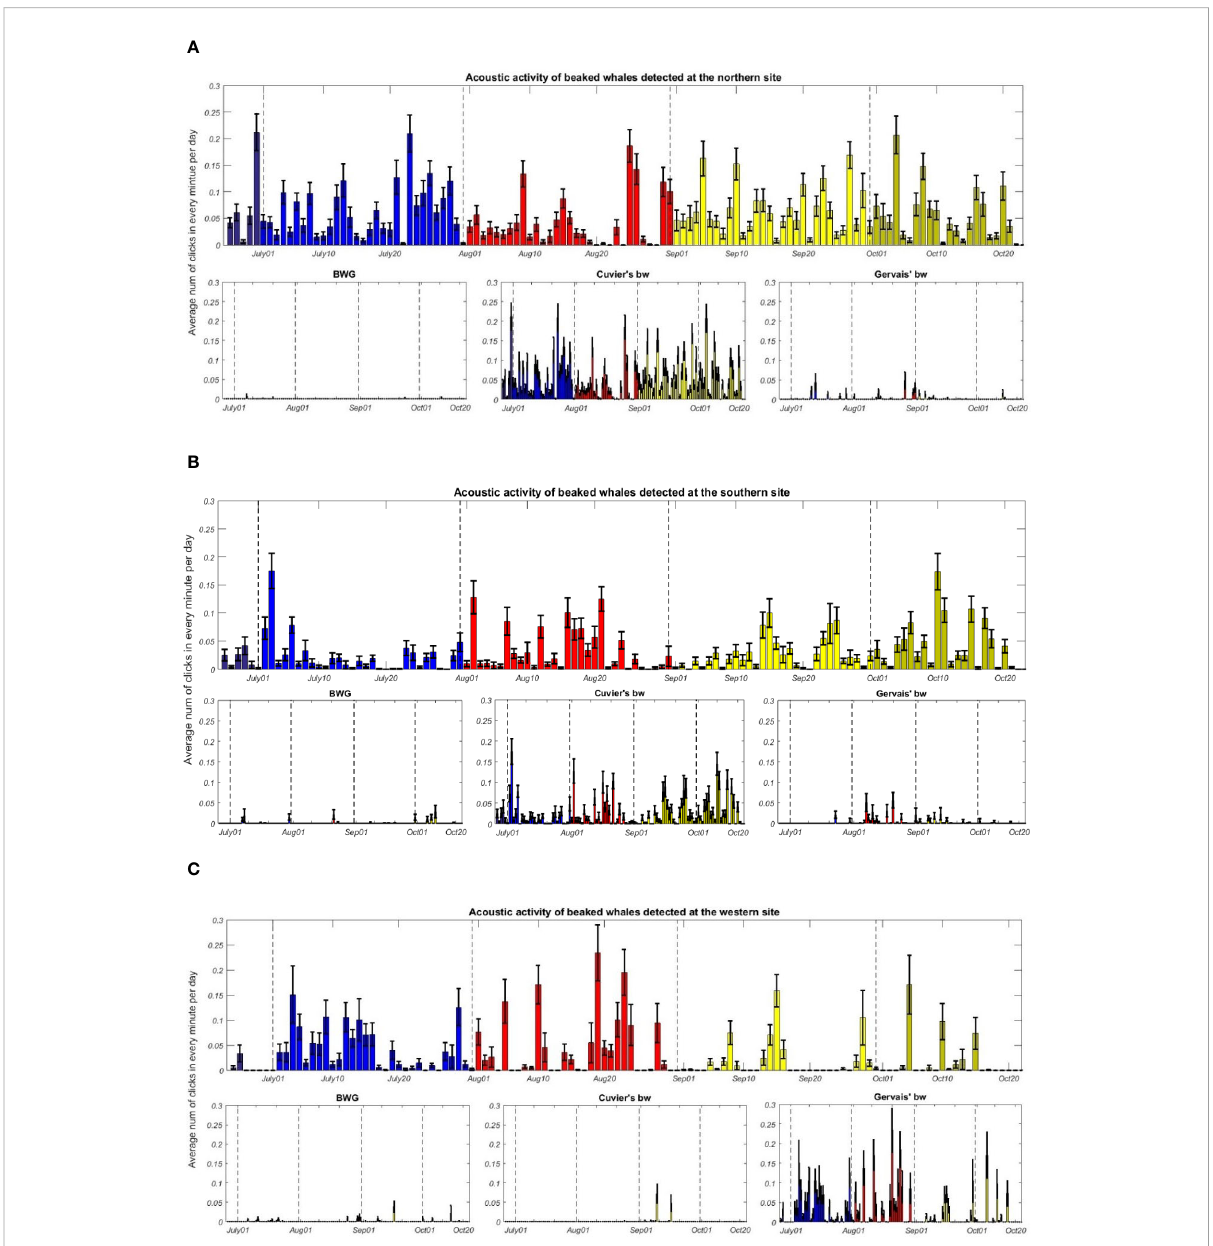
FIGURE 4 (Top) Average daily click rates of beaked whales detected at the (A) northern (N), (B) southern (S), (C) western (W) sites from June 26 to October 20, 2015. (Bottom) Average daily click rates of BWG, Cuvier ’ s, and Gervais ’ beaked whales at the N, S and W sites. Daily averages and associated standard errors are shown. Colors indicate different months (dark blue, June; blue, July; red, August; yellow, September; green,